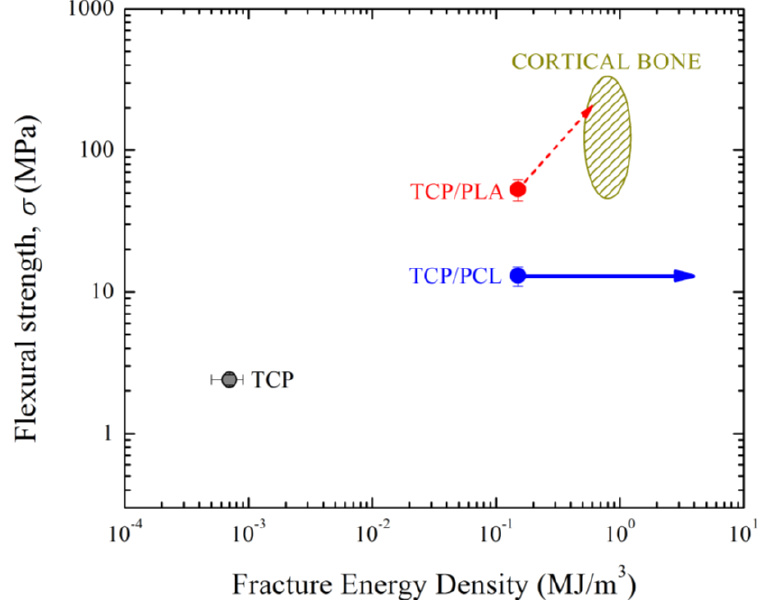
Figure 11. Ashby diagram flexural strength vs. fracture energy density comparing the properties of bare and impregnated robocast scaffold with cortical bone properties